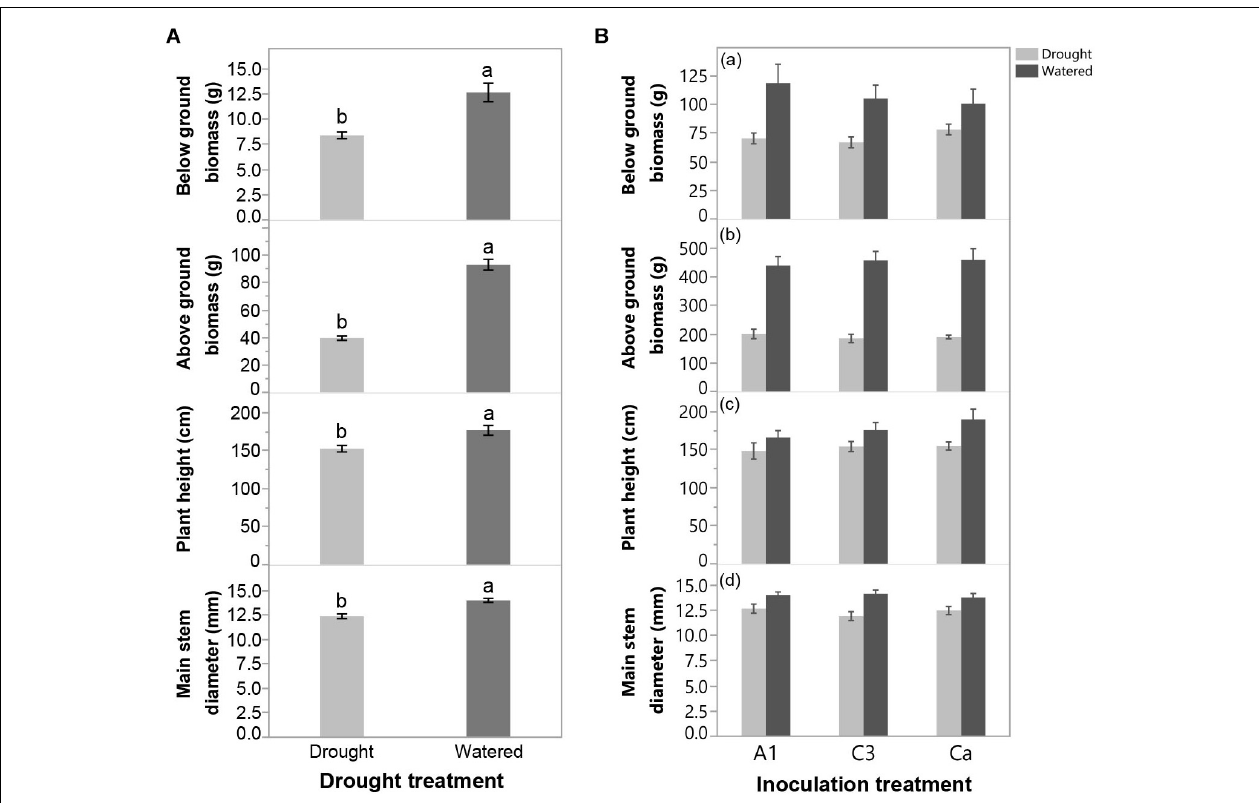
FIGURE 3 | (A) Effect of drought treatment on below ground biomass, above ground biomass, plant height and main stem diameter at the end of Experiment 2 (greenhouse trial). (B) Effect of inoculation with R. irregularis isolates C3 and A1 on below ground biomass, above ground biomass, plant height and main stem diameter at the end of Experiment 2 in either Watered or Drought treatments in Experiment 2 (greenhouse trial). Error bars represent ± S.E. Different letters above bars represent significant differences at p < 0.05 according to a Tukey post-hoc